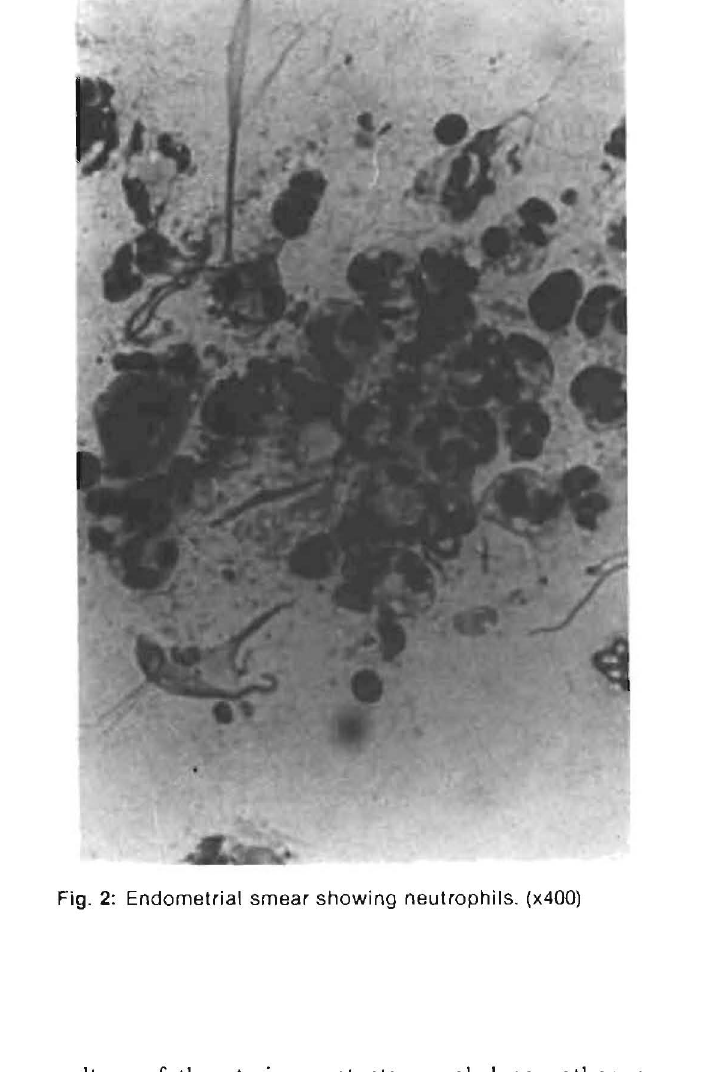
cult ure of the uterine contents revealed no pathogens and an endometrial smear showed no neutrophils. The mare was not mated during this oestrus period nor in a subsequent induced one. Oestrus cycles thereafter oc cured normally, the first of which occured 14 days after the end of the last induced one. In this oestrus period endometrial cytology and bacterial culture were again both negative, and the mare was covered. She